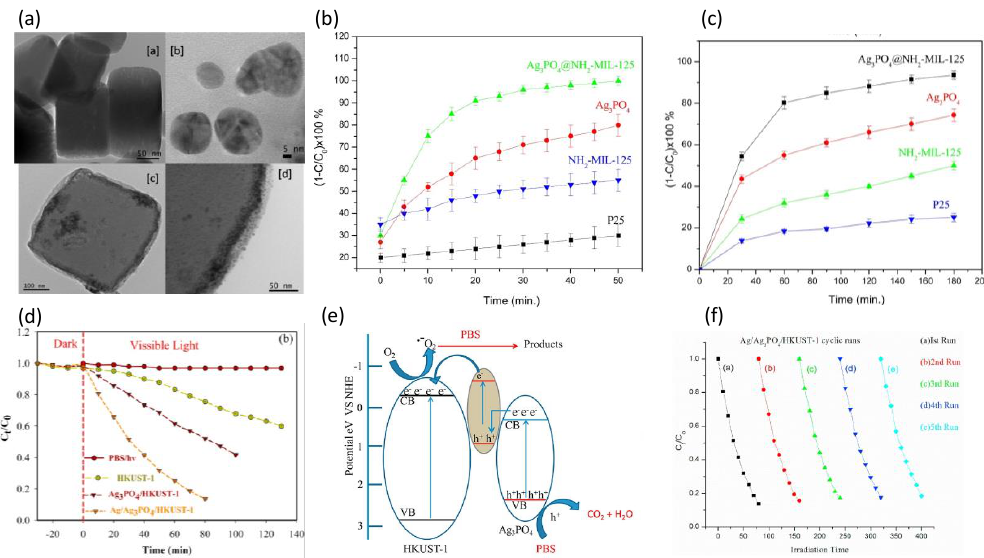
Figure 3. ( a ) TEM of (a) MIL-125-NH2, (b) Ag 3 PO 4 NPs, (c) Ag 3 PO 4 @NH 2 -MIL-125, and (d) high magnification of the particle edge of Ag 3 PO 4 @NH 2 -MIL-125. ( b ) Photocatalytic decompositions of MB with Ag 3 PO 4 , NH 2 -MIL-125, Ag 3 PO 4 @NH 2 -MIL-125 composites and commercial TiO 2 (P25) under visible-light irradiation. ( c ) Photocatalytic decompositions of RhB with Ag 3 PO 4 , NH 2 -MIL-125, Ag 3 PO 4 @NH 2 -MIL-125 composites and commercial TiO2 (P25) under